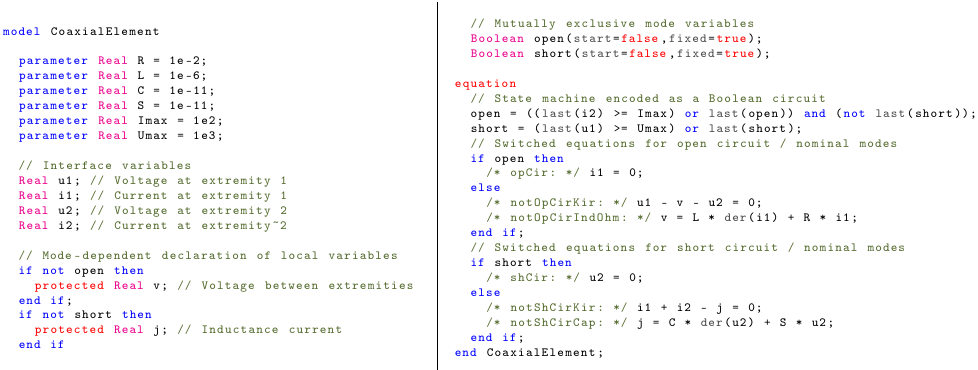
Figure 14. Variable dimension model of the faulty transmission line element.